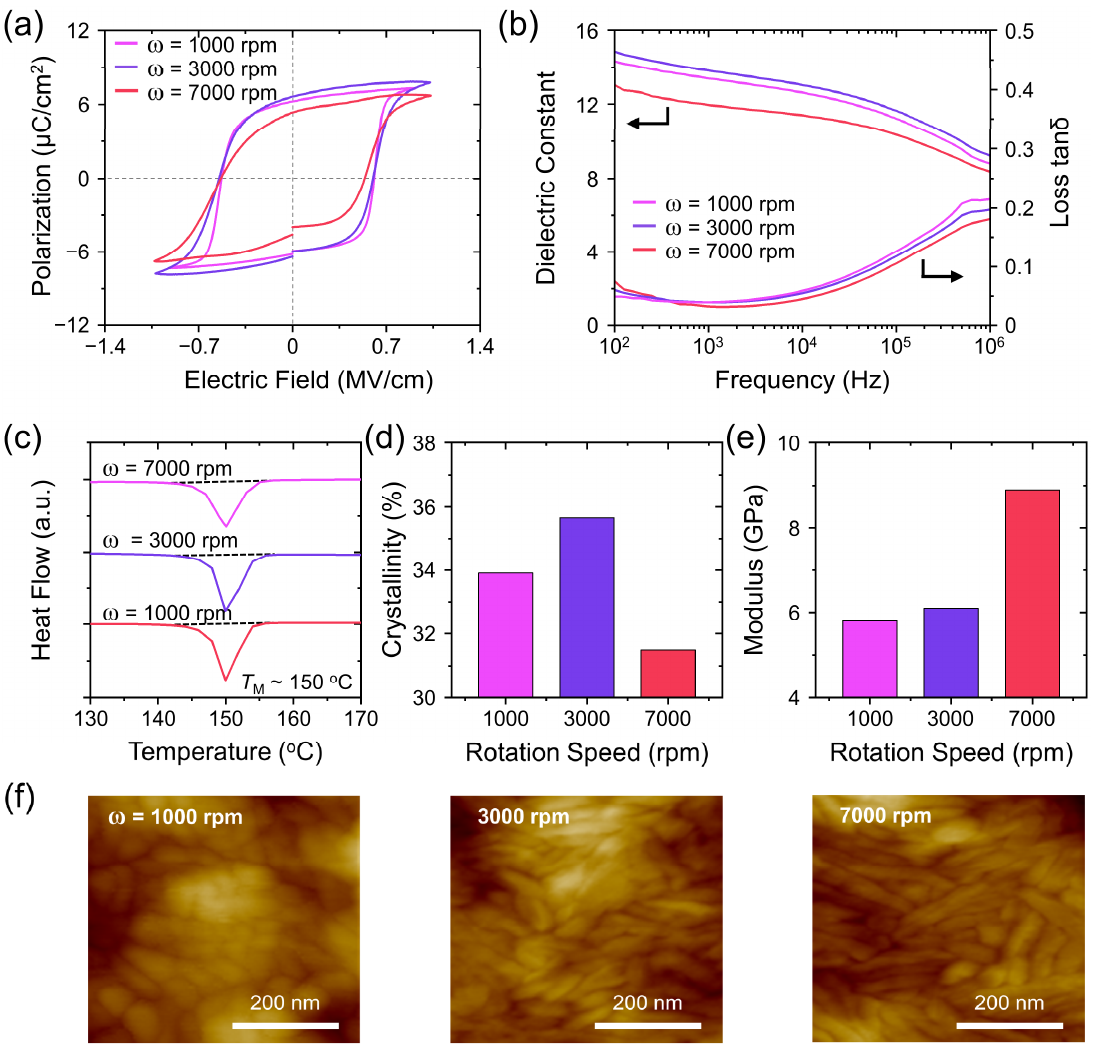
Figure 3. Rotational speed-dependent ( a ) ferroelectric hysteresis loop, ( b ) dielectric constant and loss tan δ , ( c ) differential scanning calorimetry (DSC) heating thermogram, ( d ) crystallinity, ( e ) Young’s modulus, and ( f ) surface morphology of P(VDF-TrFE) films. In ( a – f ), the distance was fixed at r = 4 cm. In ( c ), the dashed lines represent the linear baselines for the enthalpy calculation. The T M represents the melting temperature of P(VDF-TrFE). Table 2. Rotational speed-dependent physical properties of P(VDF-TrFE) films during the spin coat- ing. The distance from the center was fixed at 4 cm.